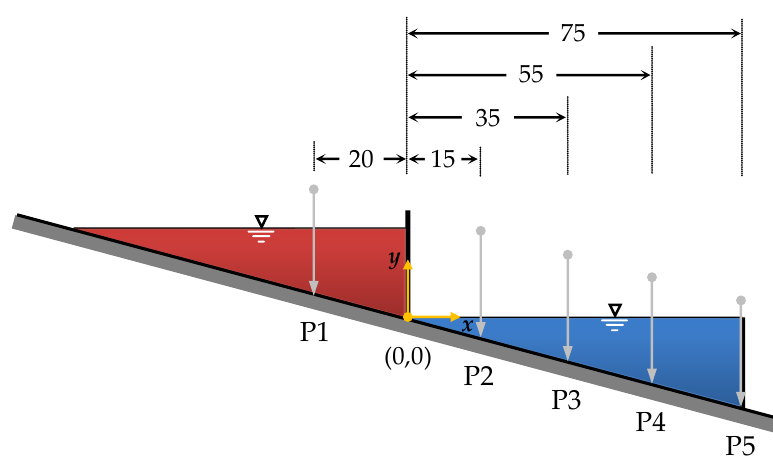
Figure 2. Locations of the five measurement points (dimensions in cm).